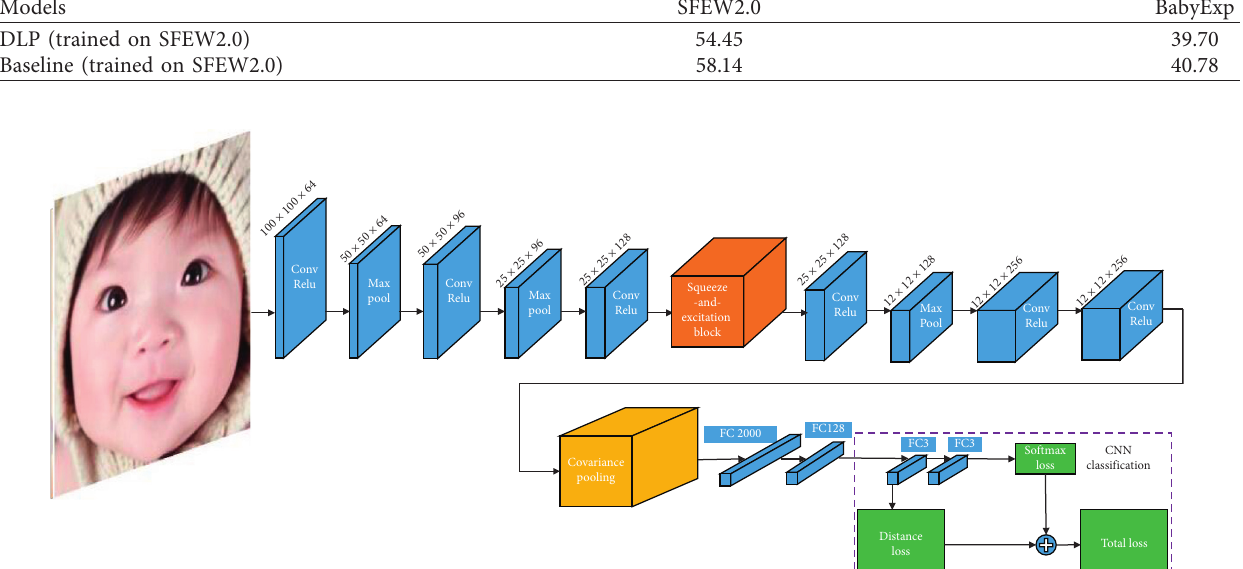
Table 3: Experimental results of adult expression recognition models on the adult and BabyExp dataset. Models